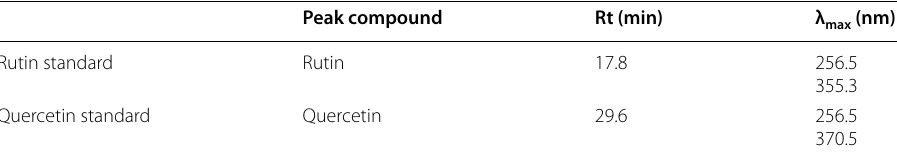
Table 2 HPLC–DAD results of Rutin standard and Quercetin standard